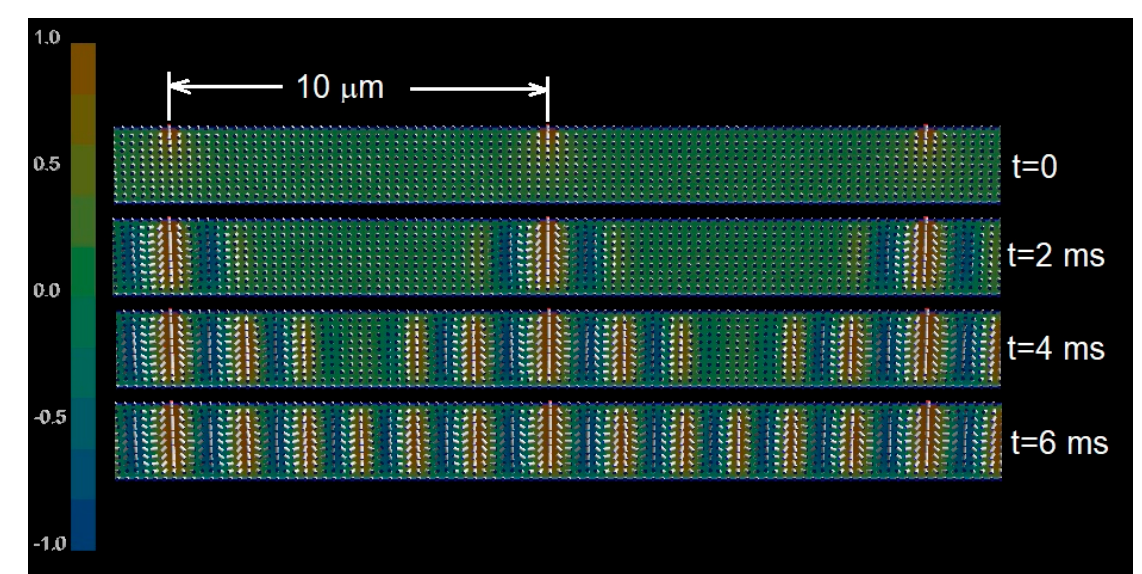
Figure 8. Dynamics of the grating induction in case of the modulated (planar–vertical) anchoring at the top alignment surface. The anchoring is modulated by the pulse function, with a period of 10 μ m and pulse width of 0.4 μ m defining the vertical alignment. The layer thickness is 2 μ m and the driving voltage is 15 V. The color scale is for the z-component of the LC director.